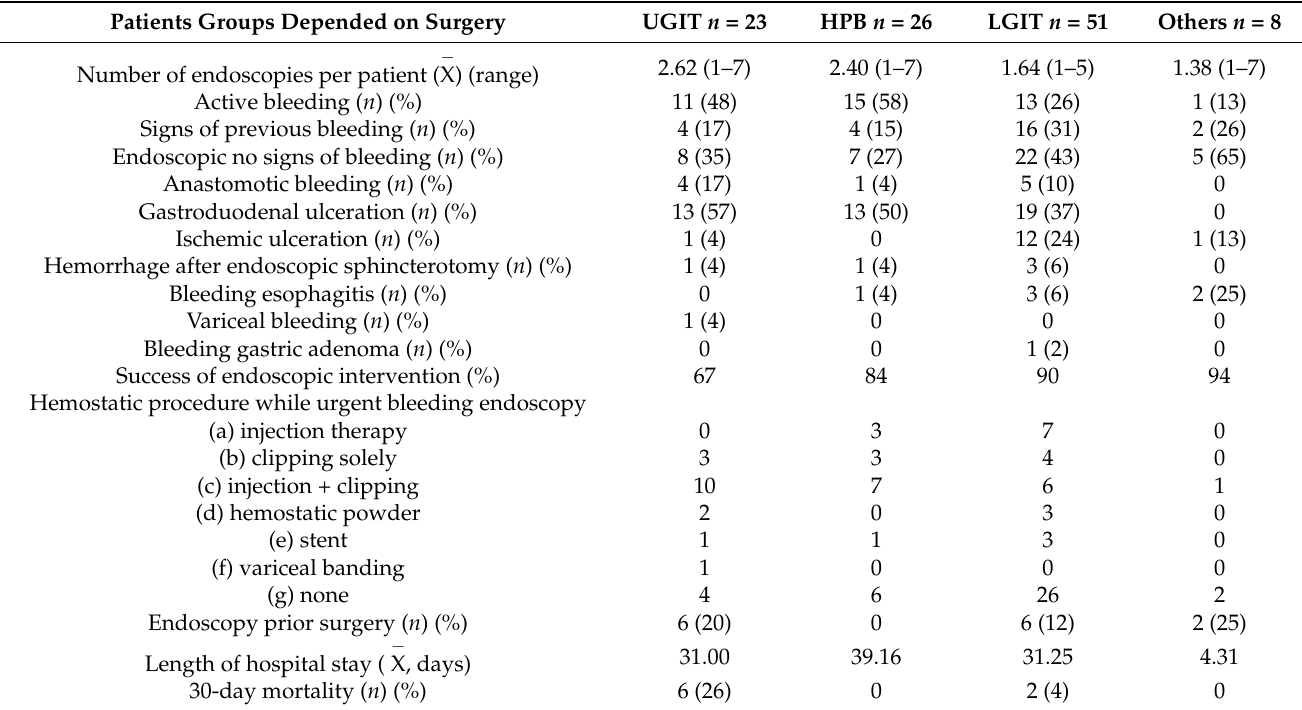
Abbreviations: UGIT = upper gastrointestinal surgery, HPB = hepatobiliary surgery, LGIT = lower gastrointestinal − surgery, n = number, X =